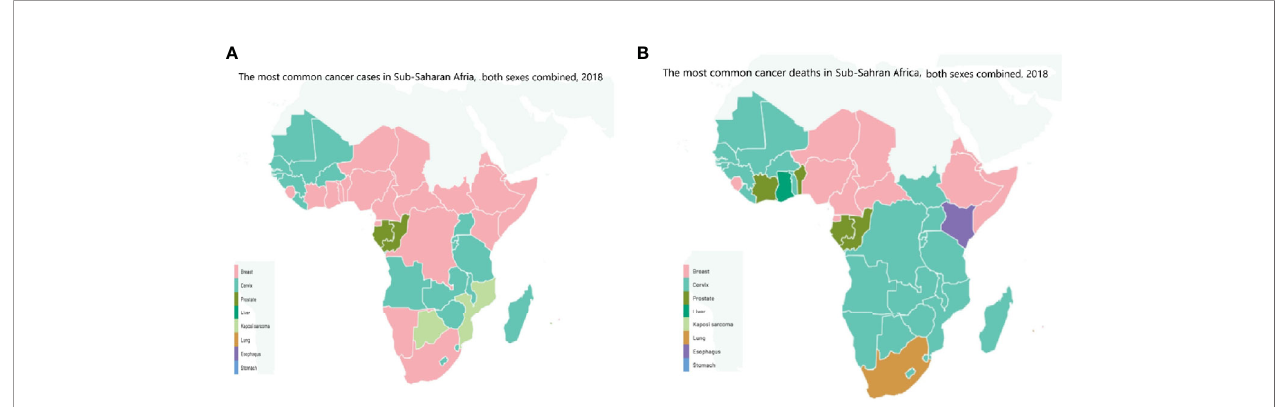
FIGURE 4 | The most common (A) cancer cases, (B) cancer deaths in Sub-Saharan Africa, both sexes combined, 2018 (3). Reproduced from "The Cancer Atlas," canceratlas.cancer.org